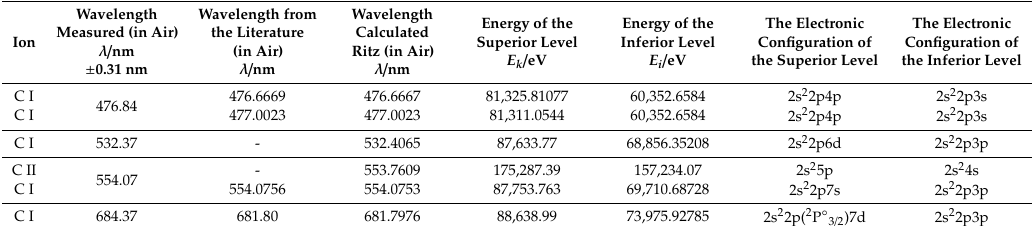
Table 6. Atomic carbon fluorescence (BTA in acetone solution with c = 1%).